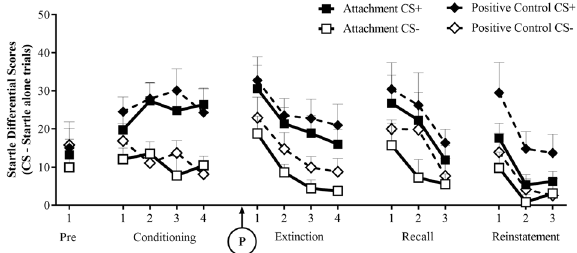
Fig. 2 Startle (mean scores + SEMs to the CS + and CS − ) during pre-conditioning, conditioning, extinction, extinction recall and reinstatement phases, respectively. Note startle scores are graphed as differential scores (compared to startle-alone trials) and averaged across groups of 4 trials. The experimental manipulation, receiving the attachment or positive control imagery task, was delivered immediately prior to the extinction phase ( ‘ P ’ on the graph). Groups differed in their level of startle during the reinstatement phase.